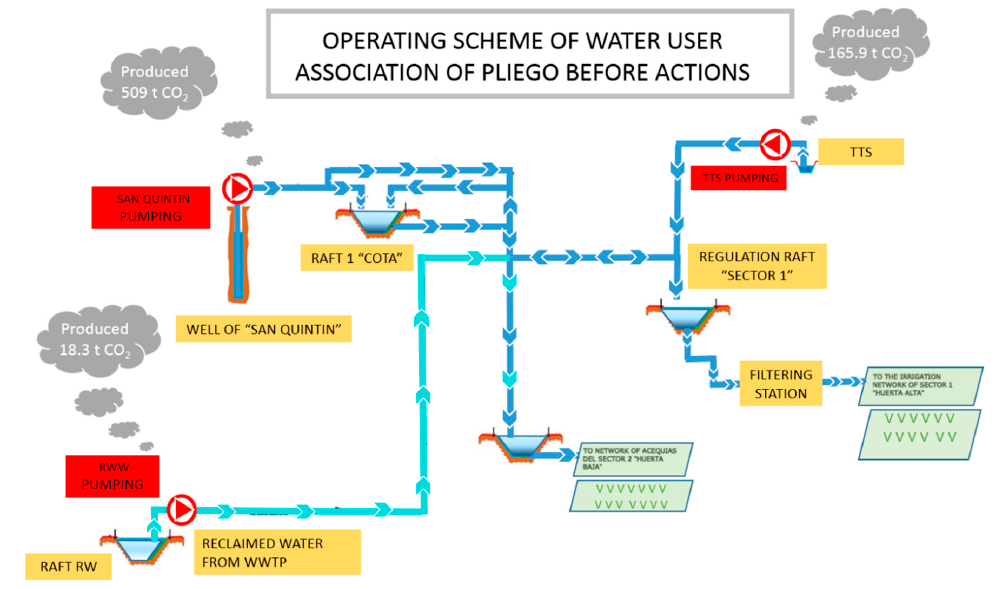
Figure 3. Current operating scheme of WUA.